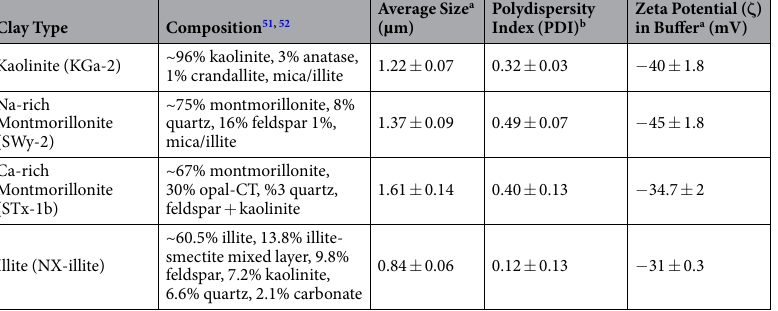
Table 1. Charge and size measurements for clay minerals. a Clay particles were suspended in 100 mM HEPES pH 7.51 buffer for measurements. b PDI has applicable range between 0.05 and 0.7, lower numbers indicate higher